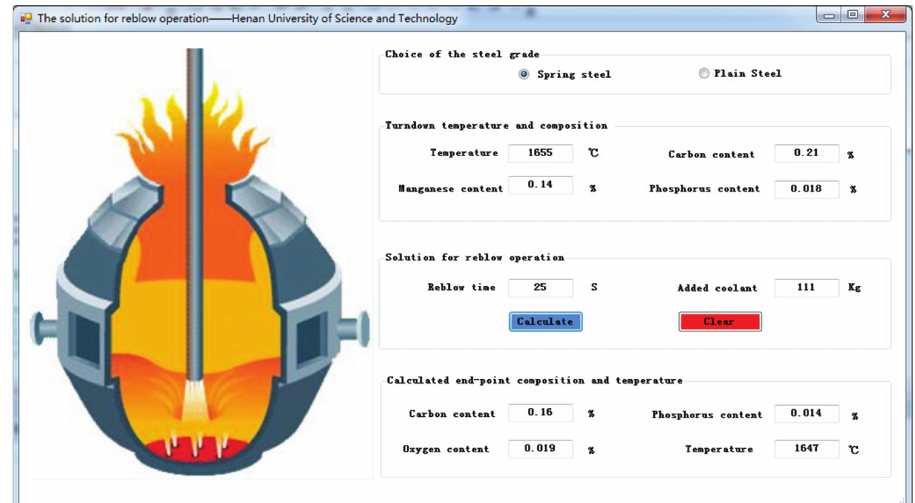
Figure 5: The interface of the software for BOF reblow operation.